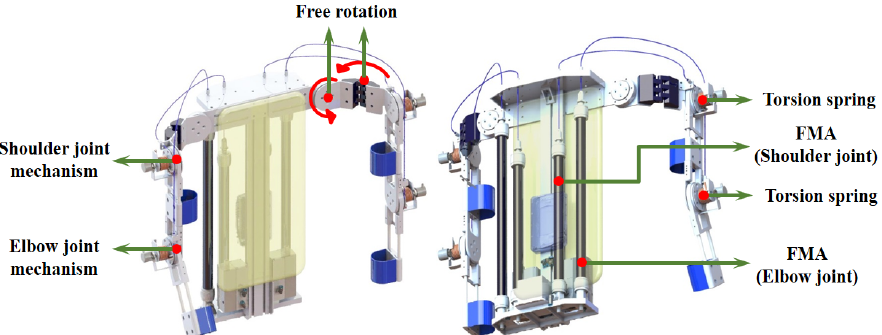
Figure 1. Computer-aided mechanical design of a wearable upper-limb rehabilitation assistance exoskeleton system (WURAES).